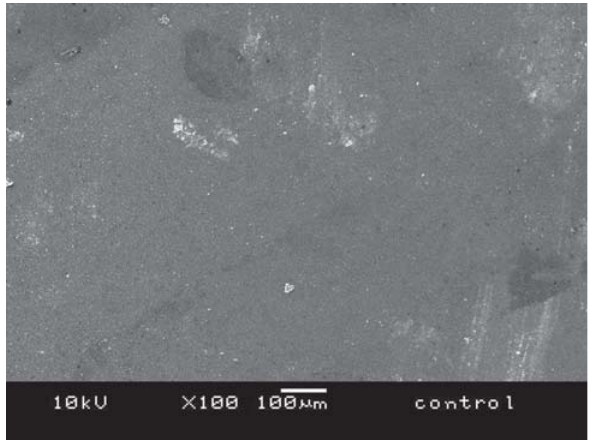
FIGURE 1- Micrograph of not scaled root surface. Note the